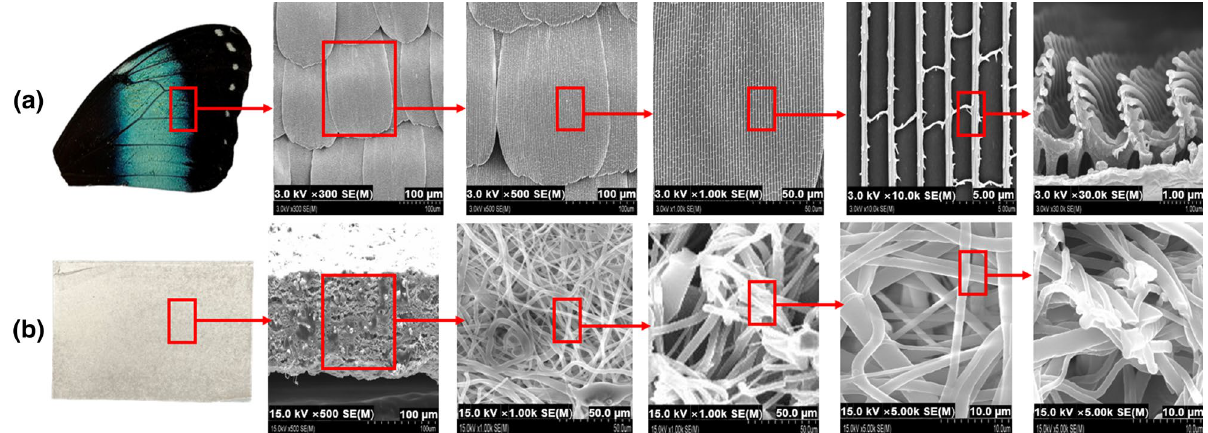
Figure 7. Electron micrographs of ( a ) a morpho butterfly wing and ( b ) the electospun paper.